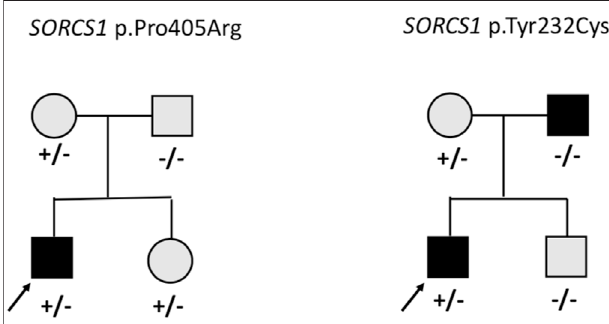
FIGURE1| Pedigreesofthefamilieswithmissensevariantsin SORCS1 . Square=male,circle = female, +/ − heterozygote, − / − wildtype. Black square/ circle = obesity, gray square/circle = overweight.